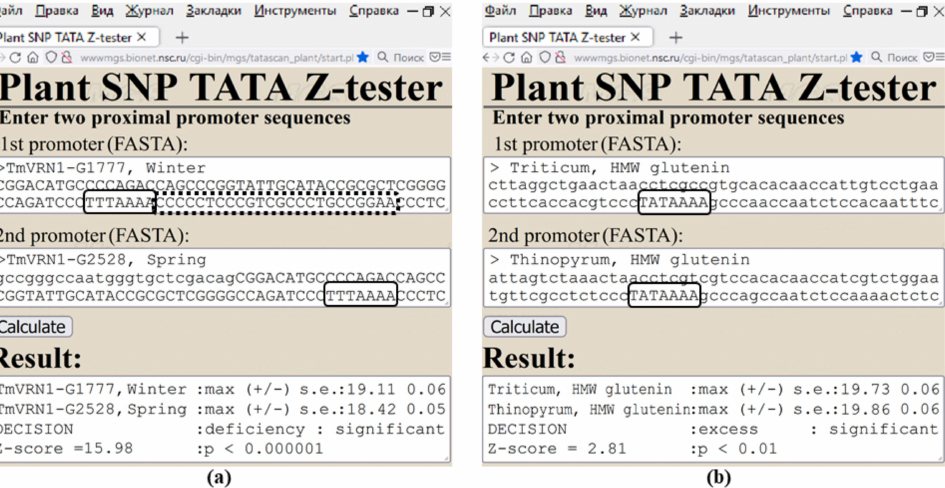
Figure 6. Examples of the output of Web service Plant_SNP_TATA_Z-tester regarding assessment of agriculturally valuable mutations in plant proximal promoters for gene expression responsive to environmental factors during wheat development. ( a ) Deletions of the spacer (dotted box) between a TBP-binding site (solid box) and a TSS of wheat gene VRN1 can downregulate vernalization protein 1 encoded by this gene, which is the widely accepted genome-wide molecular marker of spring wheats in contrast to winter wheats [69]. ( b ) Statistically significant upregulation of the glutenin high-molecular-weight (HMW) subunit, which determines the gluten level in the grain, in wheatgrass ( Thinopyrum ) as compared to wheat ( Triticum ) [70]. This result explains how, in the harsh Siberian climate, wheat–wheatgrass hybrids increase grain baking quality without yield losses in comparison with the mother wheat variety